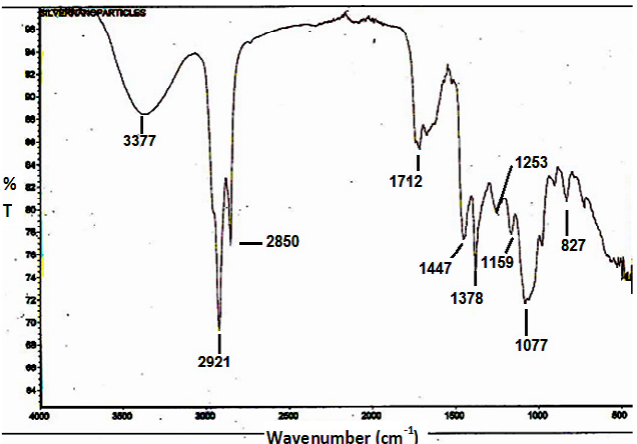
Fig. 8. FT-IR spectrum of BL-AgNPs exposed the presence of functional